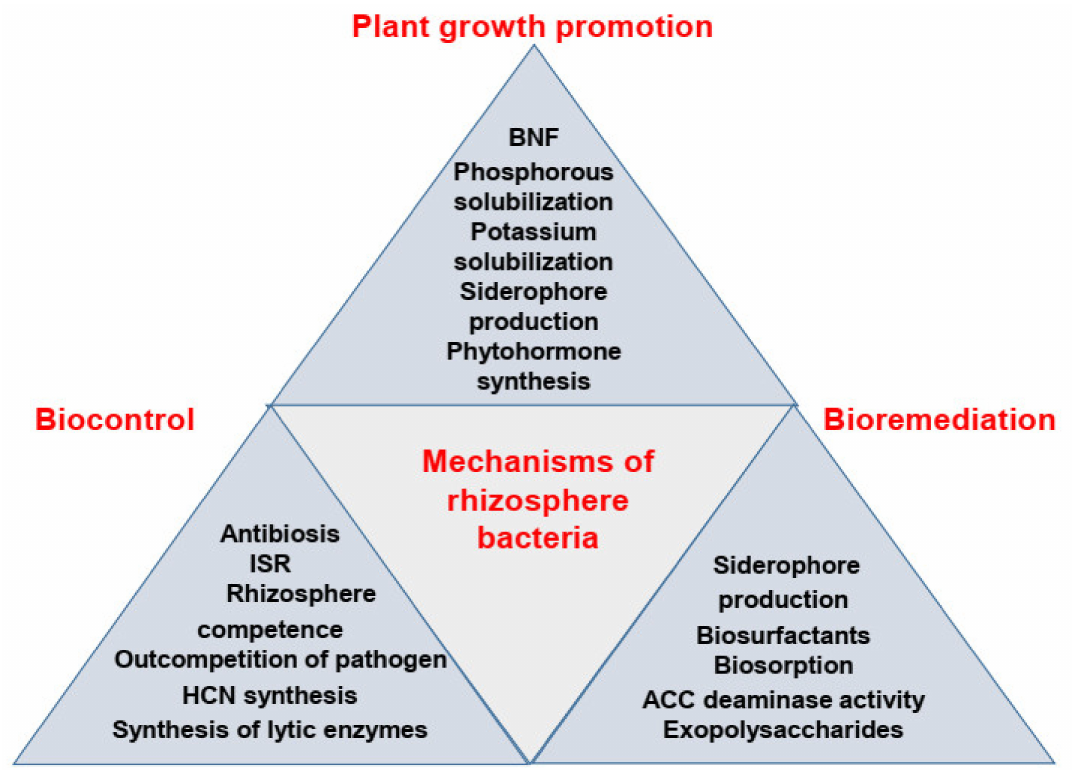
Figure 1. An overview of the mechanisms employed by rhizobacteria for plant growth promotion, biocontrol of plant pests, and bioremediation of contaminated soils. BNF, biological nitrogen fixation; ISR, induced systemic resistance; HC, hydrogen cyanide; ACC, 1-aminocyclopropane, 1-carboxylic